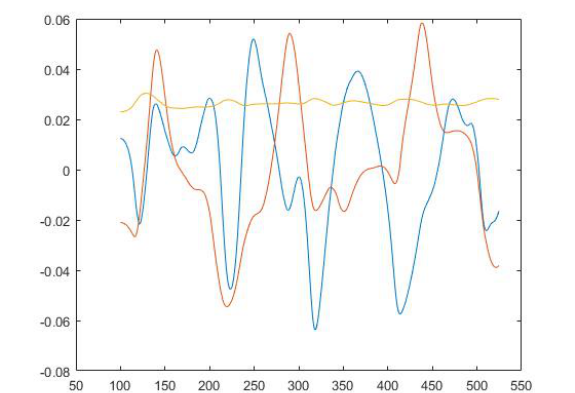
Fig. 25. The first three principal components for 20 cells in geometry A.